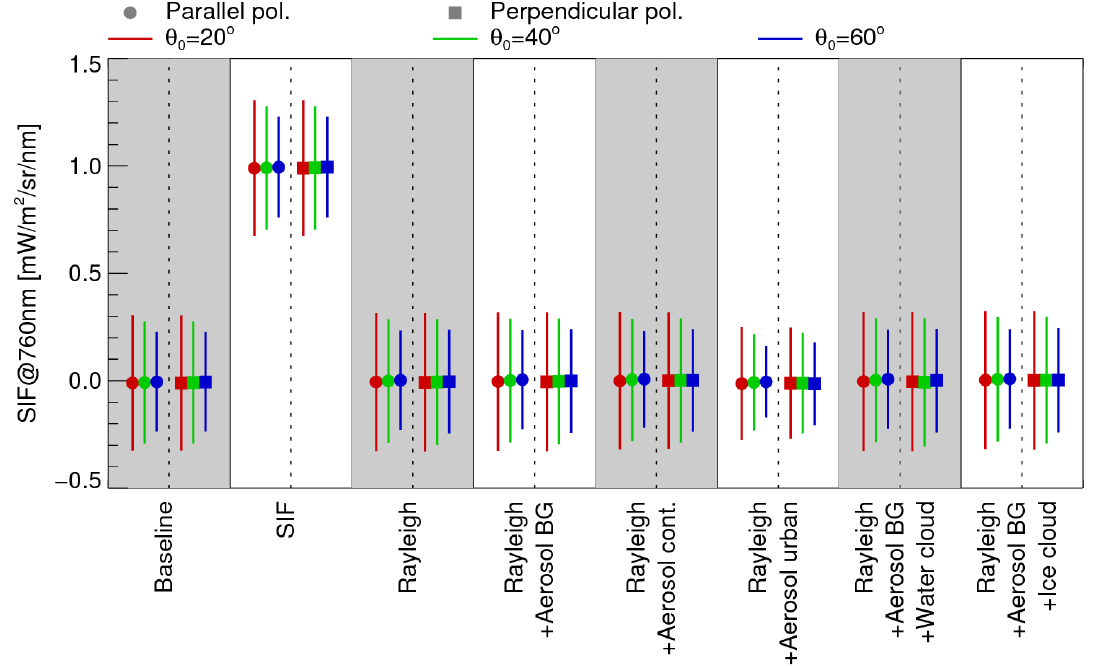
Figure 15. Retrieved solar induced chlorophyll fluorescence for the 3-Scat retrieval setup and the geophysical baseline , SIF , and all scattering related scenarios. The error bars represent the 1 σ a posteriori